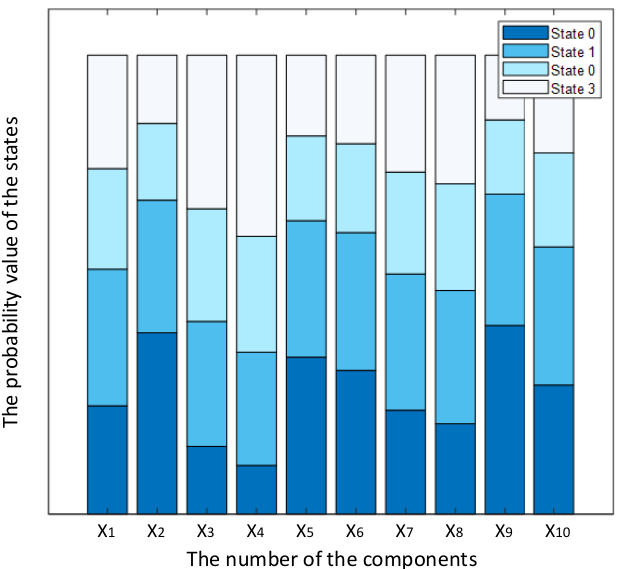
Figure 6. The probability of turbine components in different states. Table 7 shows the cross-section data of the integrated importance measure (IIM). These Table 6. The parameters of components in turbine systems. data are obtained by Equations (16) and (17). The four kinds of states of a component in a turbine are obtained. Table 7 only shows the cross-section data, and the dynamic data of IIM over time are not shown because of too much data. According to Table 7 and Equation (14), the dynamic data of recovery importance measure (RIM) is obtained in the submitted form. RIM is used to select the optimal maintenance behavior of a faulty component, rather than to select the preferred maintenance component from several